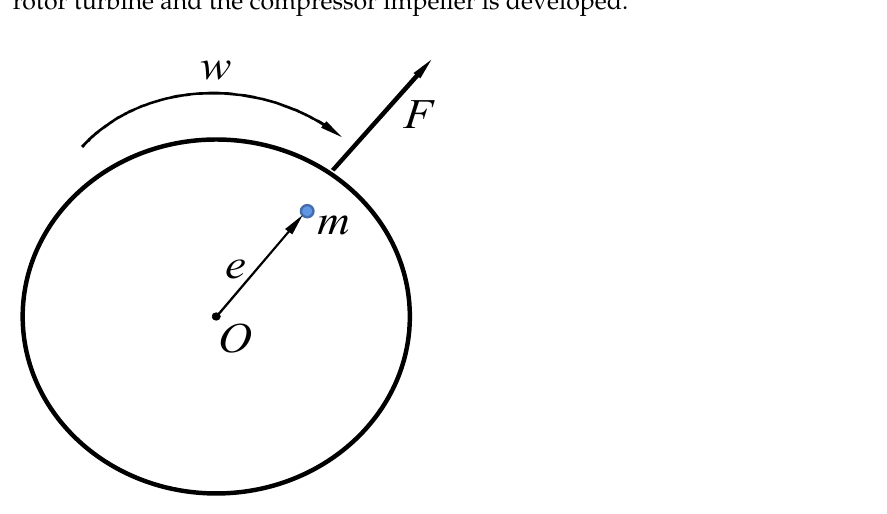
Figure 2. Diagram of the rotor unbalanced state. Note : m is the eccentric mass; e is the eccentric distance; F is the centrifugal force; w is the angular